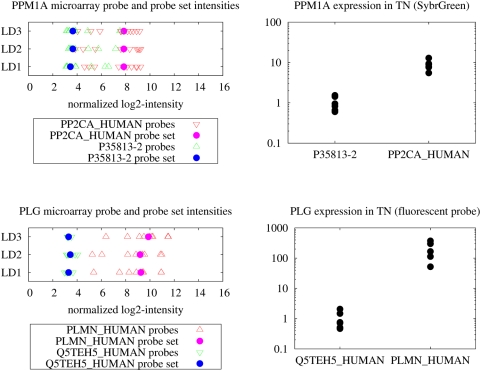
Comparison of alternative transcript abundance in microarray and real-time RT-PCR.On the left microarray signal intensities are shown for the genes PPM1A and PLG. Confirmatory real-time RT-PCR data are shown on the right. Lowly and highly abundant transcripts of the genes PPM1A and PLG were measured using microarrays in LD tissue. Transcript-specific probe intensities were background-adjusted and quantile-normalized using RMA. These are shown as single probe values (triangles) and, furthermore, as summarized transcript-specific probe set values (dots). In addition, the transcripts were quantified in the unaffected part of TN tissue using real-time RT-PCR. Real-time RT-PCR data are normalized to the transcript with lower abundance.